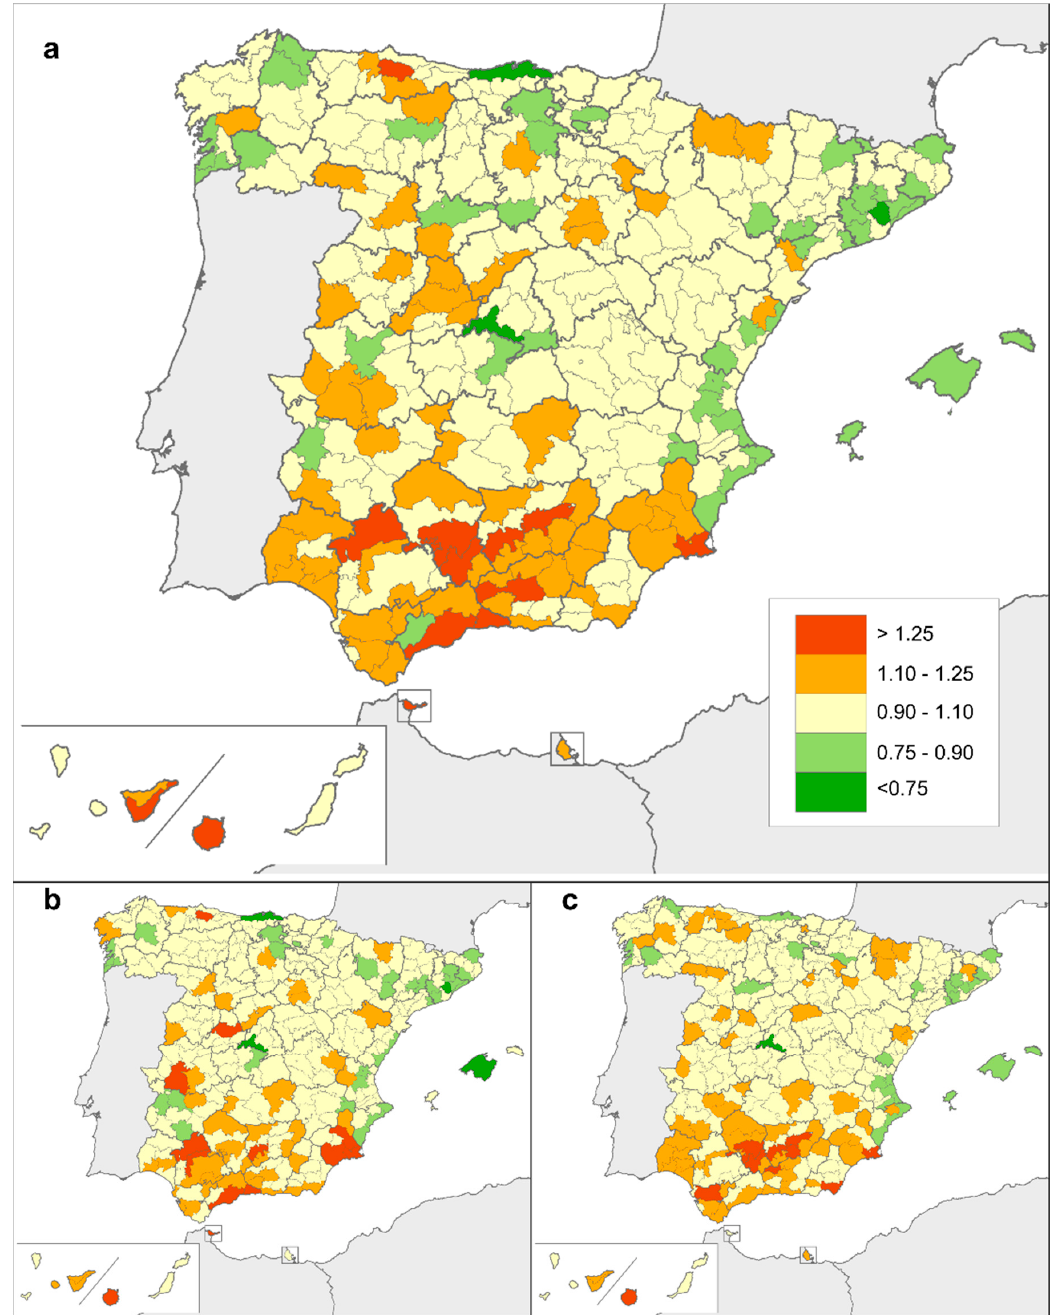
Figure 2. Smoothed standardised mortality ratios (smoothed SMRs) for rare congenital anomalies: ( a ) both sexes, ( b ) males, ( c ) females.